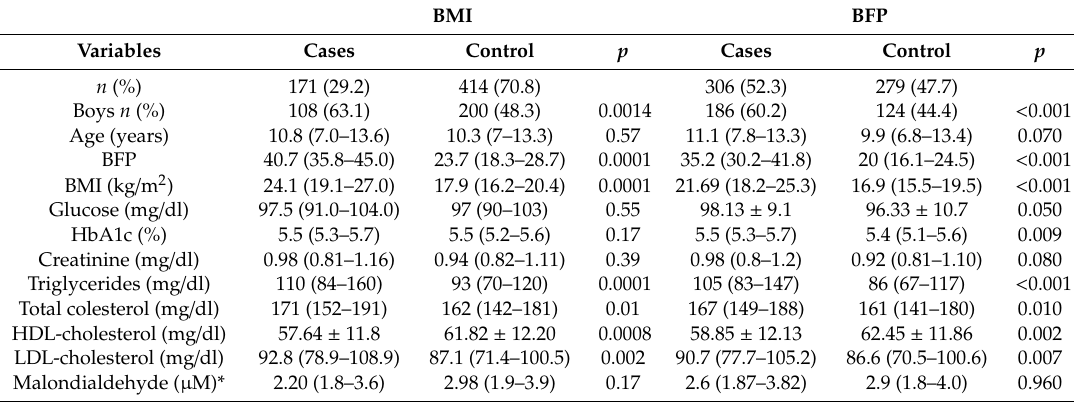
Table 1. Descriptive characteristics of Mexican children cases and controls classified according to their body mass indexes (BMIs) or body fat percentages